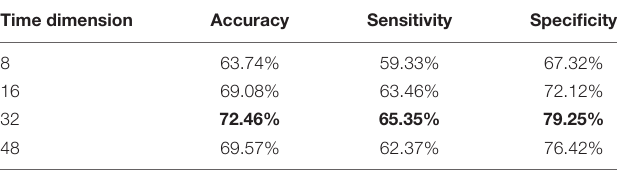
The bold values in this table represent the optimal values of accuracy, specificity and sensitivity.